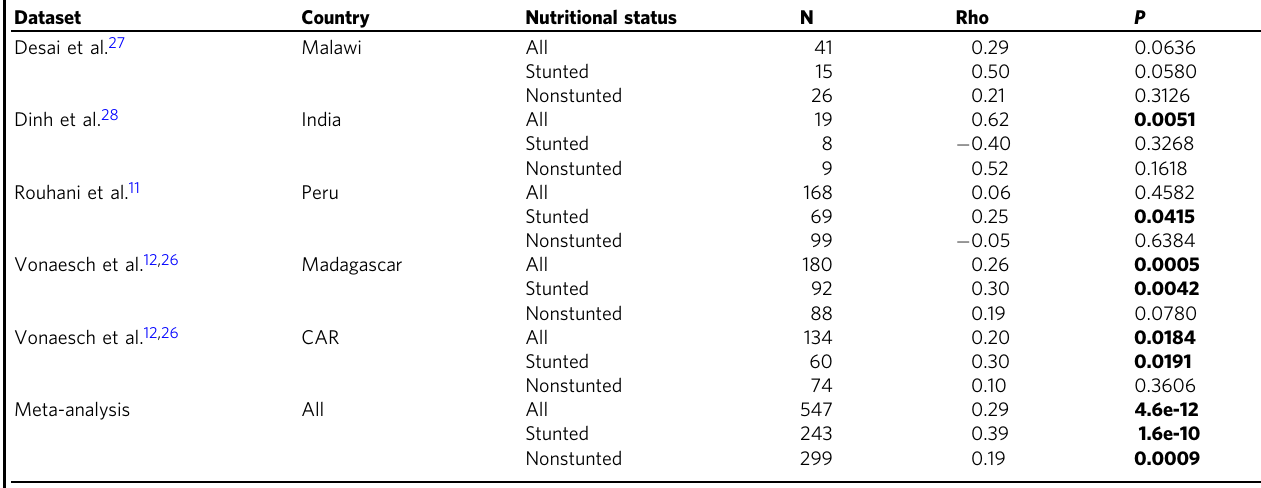
Table 1 Summary of two-sided Spearman ’ s correlations between Bacteroidaceae and Enterobacteriaceae log-adjusted relative abundance in 16S rRNA sequencing datasets, in samples where both taxa are